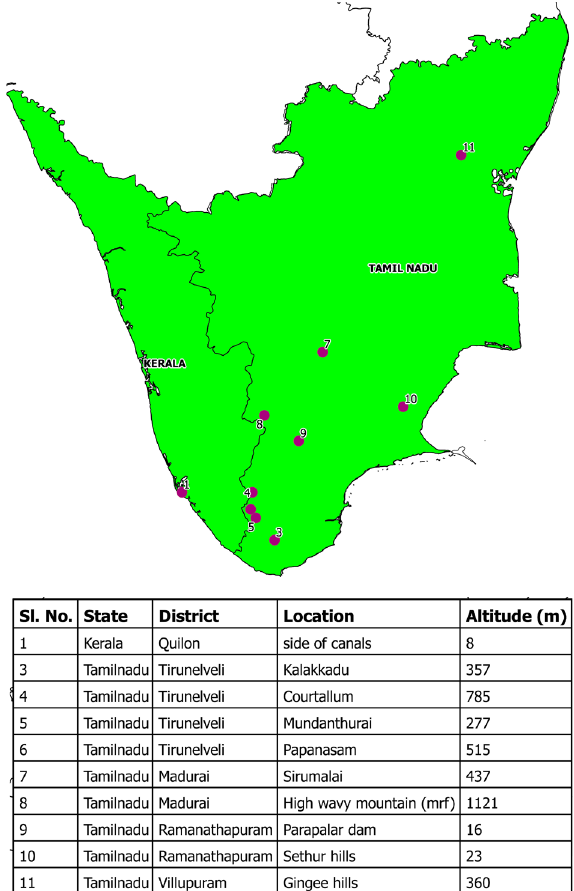
Figure 3. Distribution of Premna